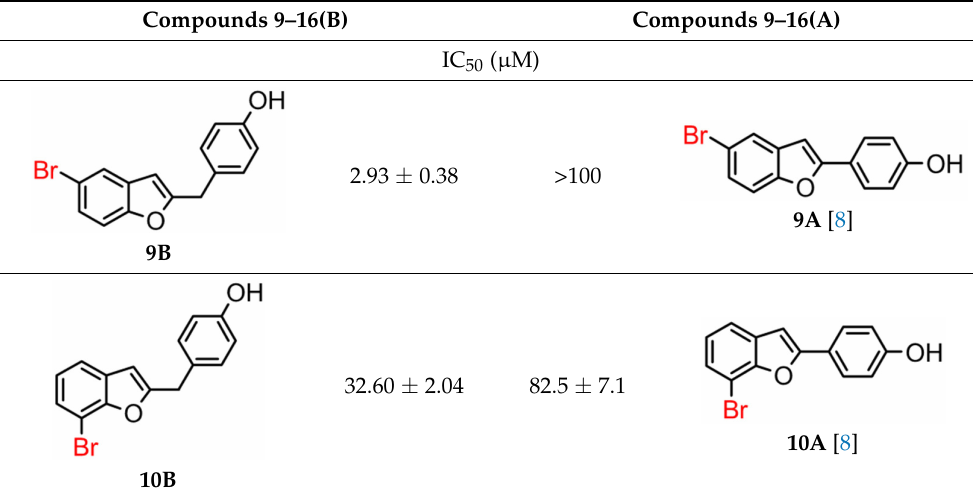
Table 1. Inhibitory effect (IC 50 ) of compounds 9 – 16 ( A ) and 9 – 16 ( B ) on BChE activity. The data shown are the mean ± SD of three independent